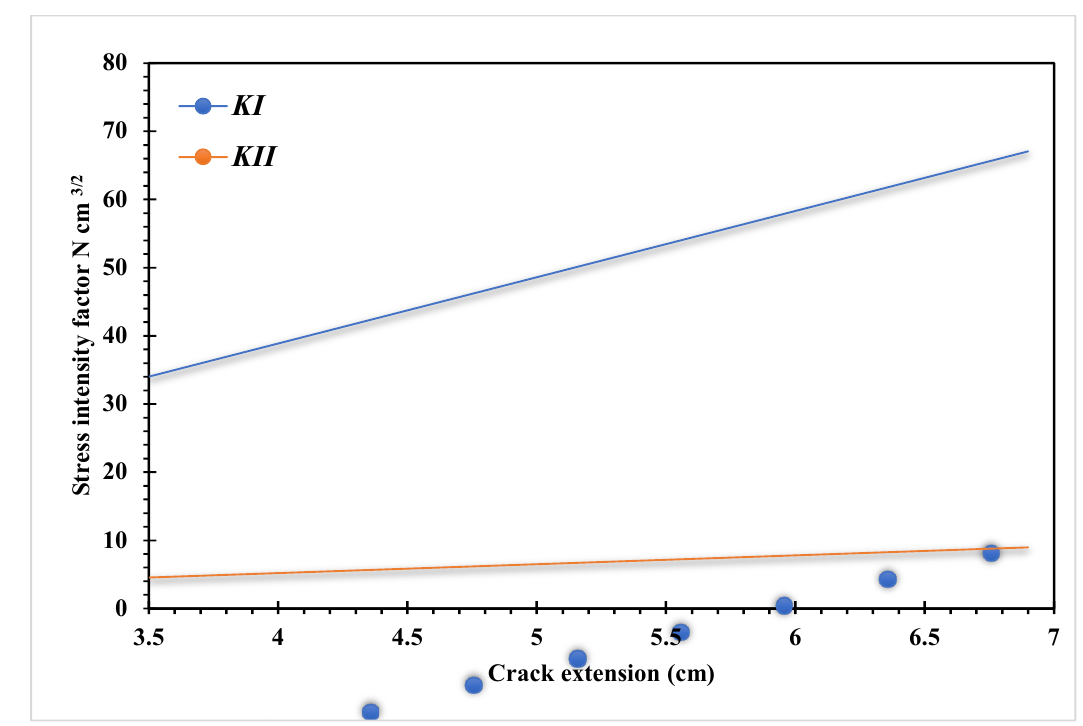
Figure 11. Stress intensity factors for each step of crack growth.